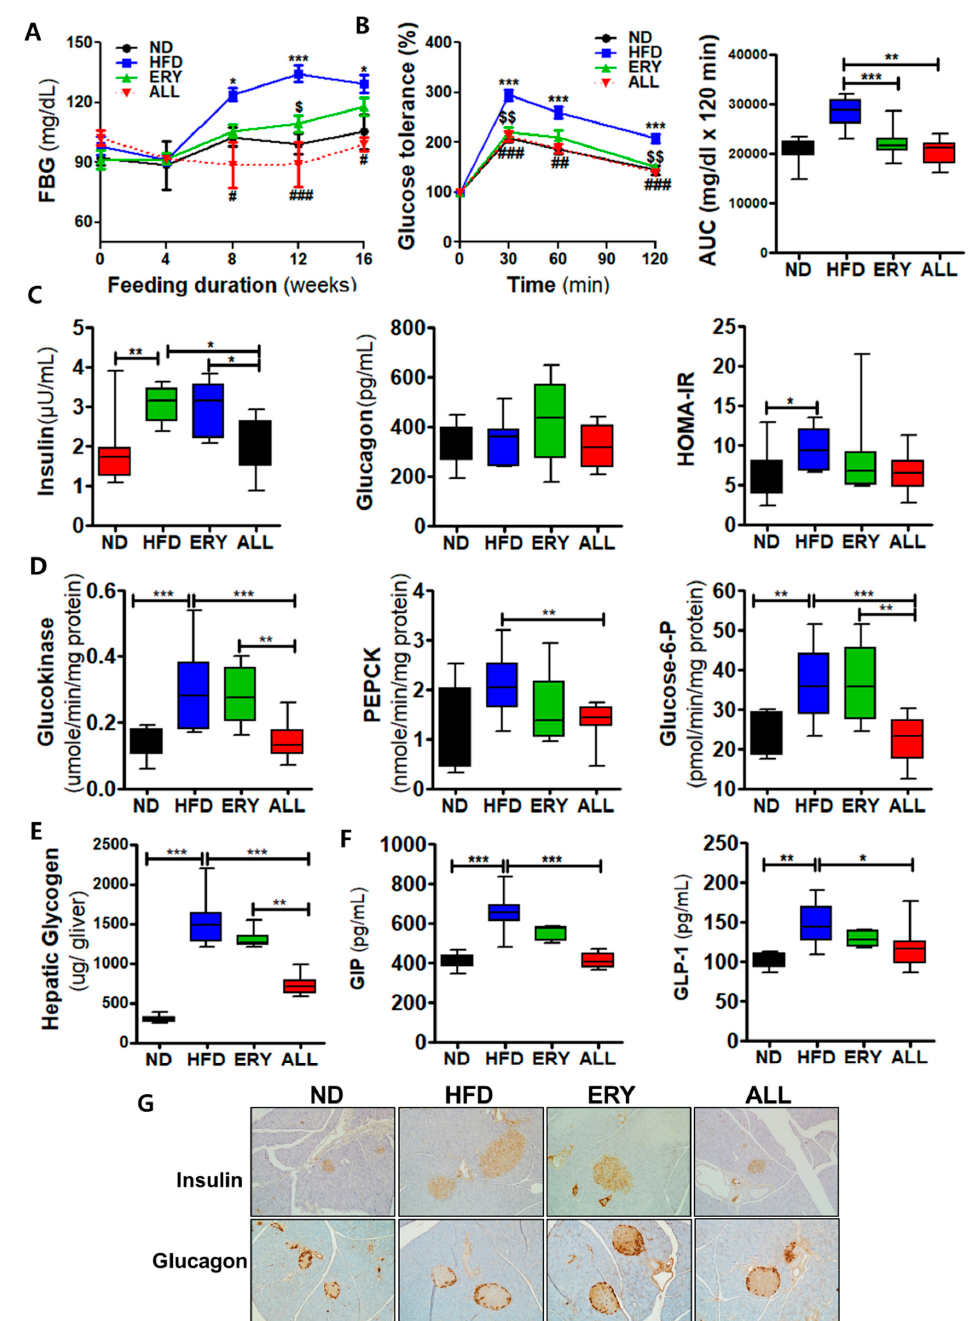
Figure 2. Effect of 16-week D-allulose supplementation on insulin resistance-related biomarkers in C57BL/6J mice fed a high-fat diet. ( A ) Changes in FBG levels. ( B ) Intraperitoneal glucose tolerance test and area under the curve (AUC). ( C ) Plasma insulin, glucagon, and homeostatic model assessment of insulin resistance (HOMA-IR). ( D ) Hepatic glucose metabolism-related enzyme activity. ( E ) Plasma gastric-inhibitory polypeptide (GIP) and glucagon-like peptide 1 (GLP-1) levels. ( F ) Hepatic glycogen. ( G ) Immunohistochemistry staining for insulin and glucagon in the pancreas (200 × magnification); Data are presented as the mean ± SE. Kruskal-Wallis test; * p < 0.05, ** p < 0.01, *** p < 0.001 versus control; ND, normal diet; HFD, high-fat diet (20% fat, 1% cholesterol); ERY (HFD + 5% Erythritol); ALL, (HFD + 5% D-allulose); FFA, free fatty acid; TC, total cholesterol; HDL-C, high-density lipoprotein cholesterol, ApoA1, apolipoprotein A1; ApoB, apolipoprotein B; non-HDL-C = (TC) –